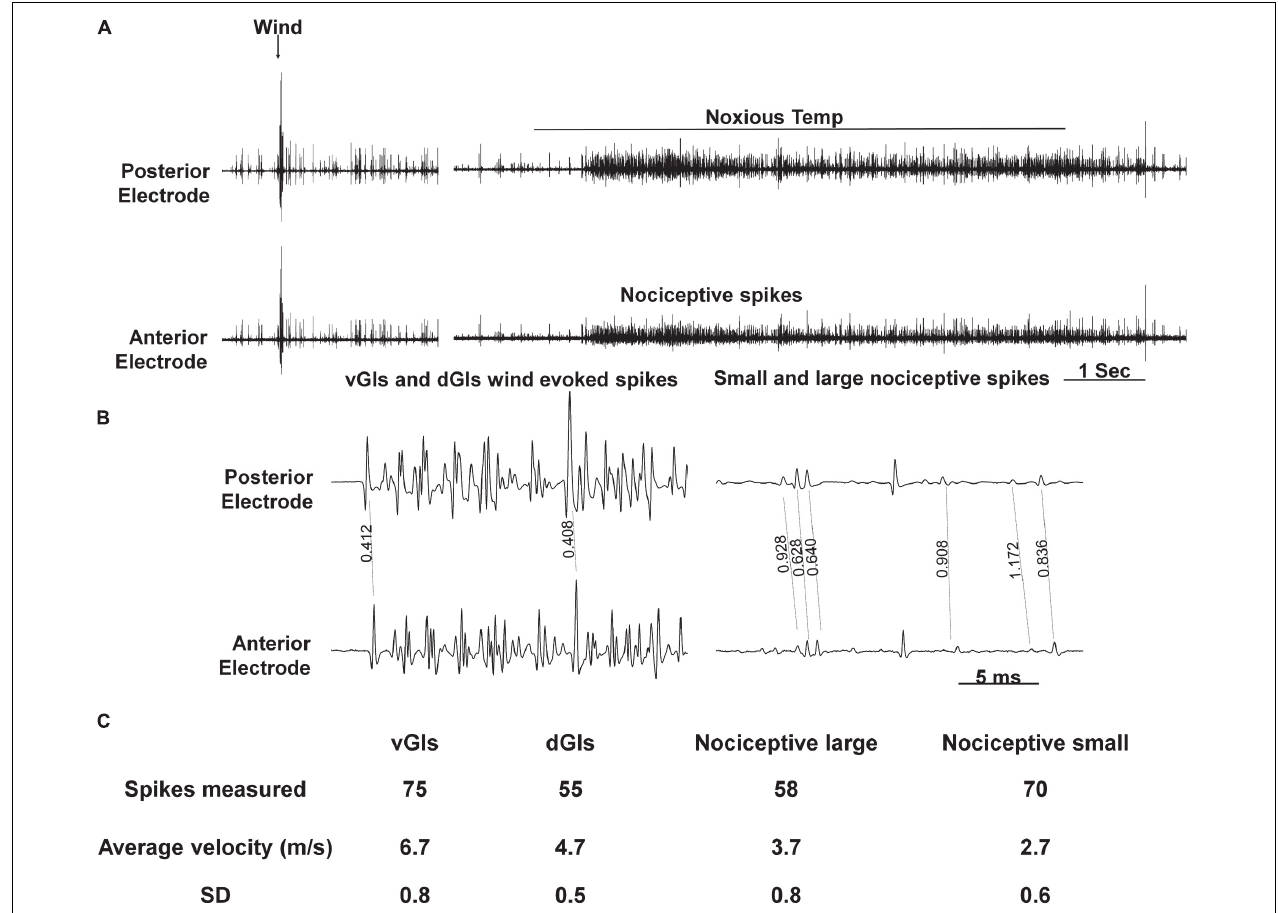
FIGURE 5 | Conduction velocity of nociceptive projections neurons is two to three-fold slower than that of wind projection interneurons. (A) Response of interneurons in the nerve cord to a wind stimulus (left) and a continuous transition between tactile and noxious stimuli (right). Two electrodes were used to measure velocity (upper and lower traces represent posterior and anterior electrodes, respectively). (B) Enlarged time scale of the traces in panel (A) . Time differences (in seconds) between two similar spikes are shown. (C) A table summarizing the data from conduction velocity